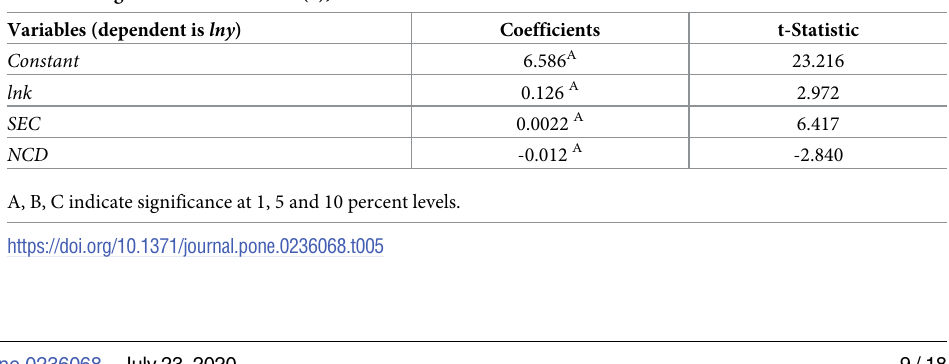
Table 5. Long-run results of model (4), 1972–2016. Variables (dependent is lny )